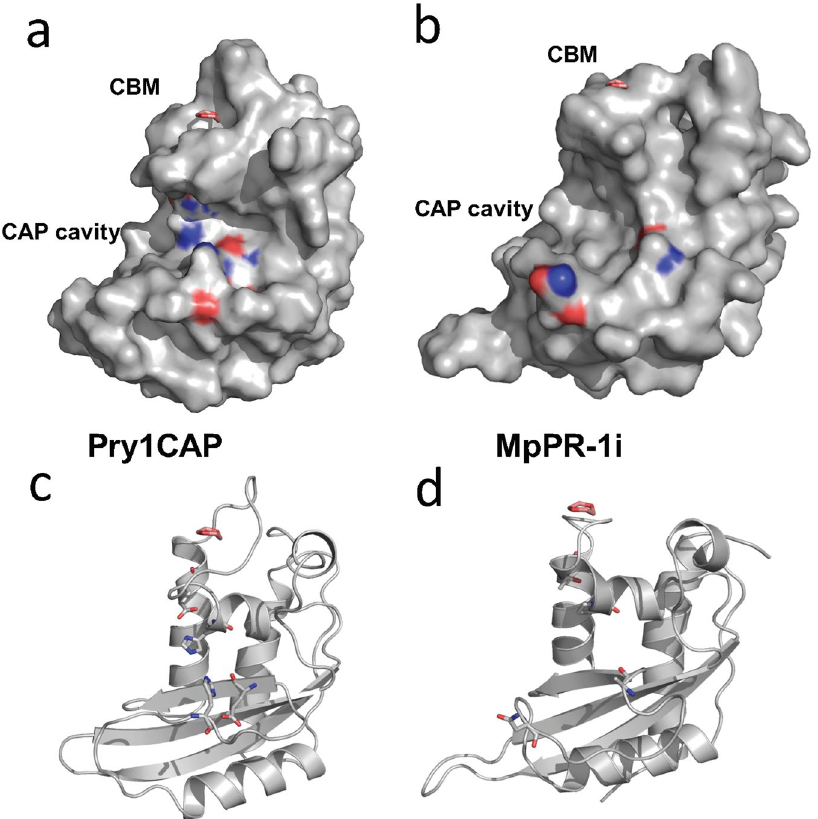
Figure 3. Comparison of CAP cavity of Pry1CAP and MpPR-1i. ( a ) Surface diagram of Pry1CAP and ( b ) MpPR-1i reveal central CAP cavity and Caveolin-binding motif (CBM) containing dioxane (orange stick), ribbon diagram of equivalent view of ( c ) Pry1CAP and ( d ) MpPR-1i monomer showing CBM containing dioxane (orange stick) and CAP tetrad